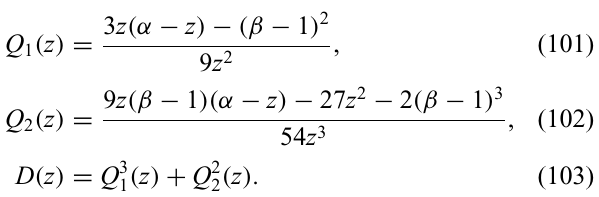
= 2 and N = 6. The shaded regions indicate A 1 2